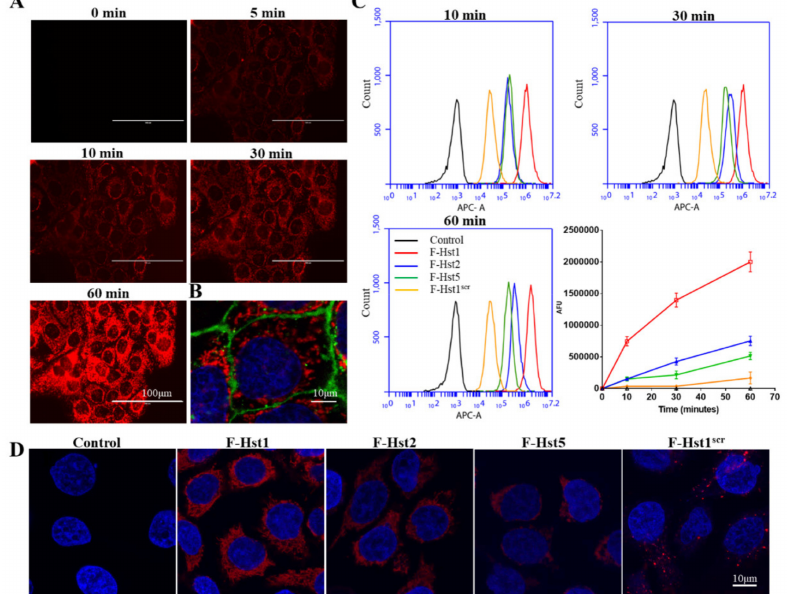
Figure 1. Cellular uptake of the ATTO-647 labeled Hst1 (F-Hst1), F-Hst2, F-Hst5 and F-Hst1 scr by human buccal epithelial carcinoma HO1N1 epithelial cells. ( A ) Fluorescent micrographs showed that the association of F-Hst1 (in red) with the cells became detectable as early as 5 min and increased with time; ( B ) confocal laser scanning microscopy (CLSM) image showed F-Hst1 (in red) distributed mainly between cell membrane (in green) and nuclei (in blue), which indicated that F-Hst1 was internalized into intracellular space; ( C ) flow cytometric analysis showed the time-course fluorescence density of cell-associated F-Hst1, F-Hst2, F-Hst5 and F-Hst1 scr . At all the time points (10, 30 and 60 min), F-Hst1 showed significantly higher fluorescence density than F-Hst2 or F-Hst5. In contrast, Hst scr showed only mild fluorescence density. Data were presented as mean ± SD. ( D ) In line with the flow cytometric data, CLSM images showed that the highest level of accumulation in epithelial cells was observed with F-Hst1, followed by F-Hst2 > F-Hst5 > F-Hst1 scr